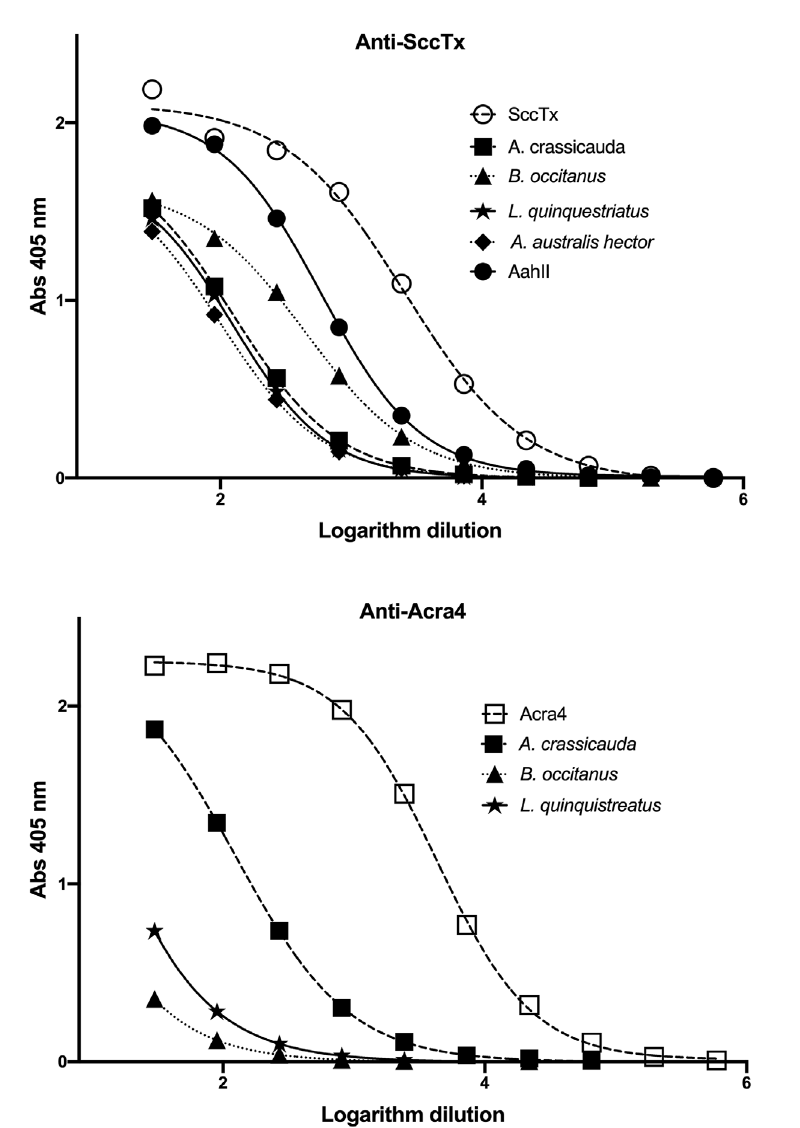
Figure 5. Antibody recognition of rabbit IgGs to venoms from North Africa and Middle East scorpion species. Rabbit hyper-immune sera raised against HisrAcra4 or HisrSccTx were titrated by ELISA using different venoms of North Africa and Middle East scorpion species. Points represent the mean ± SD of triplicate wells of the